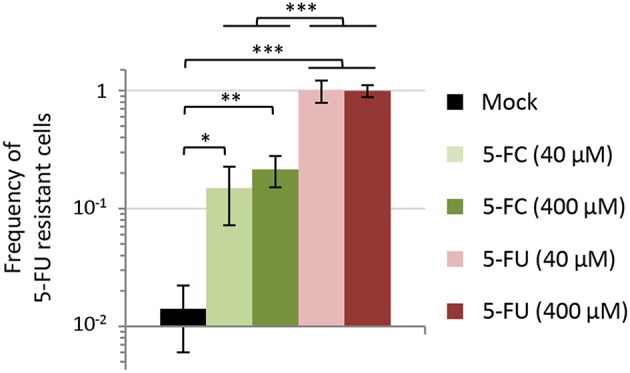
Effect of 5-fluorocytosine (5-FC) and 5-fluorouracil (5-FU) at 40 or 400 μM on the competitive fitness of spontaneous 5-FU resistant mutants of P. aeruginosa PAO1. Each 5-FU resistant isolate (R1, R2, R3, R4, or R5) and the parental strain PAO1 were precultured in TSBD with 50 μM FeCl3 and then inoculated at 1:1,000 final dilution in TSBD in a 1:100 ratio (5-FU R:WT). Percentage of 5-FU resistant cells with respect to 5-FU sensitive ones was evaluated after 16-h incubation at 37°C by plating on SM9 agar plates with or without 120 μM 5-FU. Values represent the mean (±SD) of ten independent experiments (two for each 5-FU resistant isolate). Asterisks indicate statistically significant differences (*P < 0.05, **P < 0.01, ***P < 0.001; ANOVA).